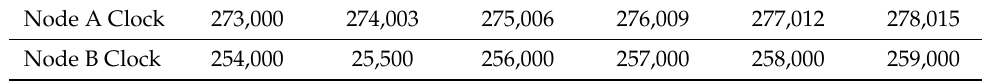
Table 1. Values of software clocks after 1000